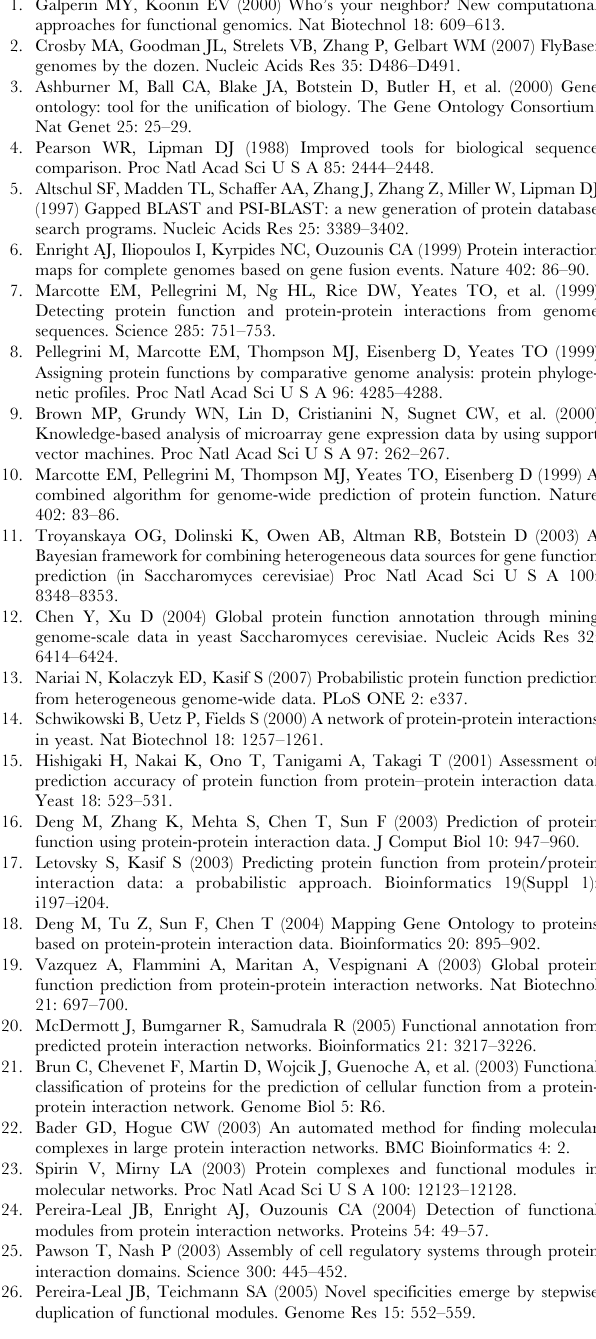
Table S1 Novel functional annotations for some H.sapiens proteins found with supporting evidences. For each human protein in the 1st column, highlighted terms in the 2nd column are the GO terms that CSIDOP predicted and also supported by evidence found in other databases or literature. The evidence is shown in the 3rd column where it lists the orthologous or paralogous proteins annotated with these highlighted terms inferred using different techniques. For example, we predicted the protein Q96A23 to have the function GO:0001786, and we found that its paralog Q99829 protein in H. sapiens is detected with GO:0001786 through the evidence code IDA. InterPro is a